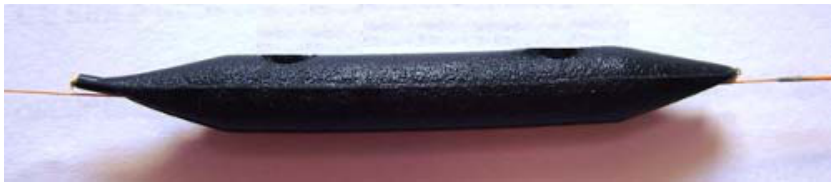
Figure 4. Photograph of the FBG hydrophones coated with UR5041.